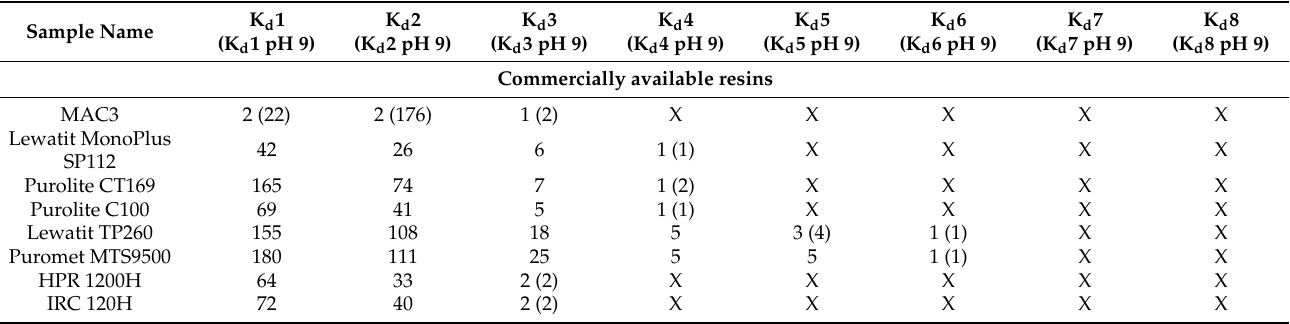
Table 2. Influence of brine composition on the distribution coefficients (K d ) of lithium ions—results from a multi-stage screening